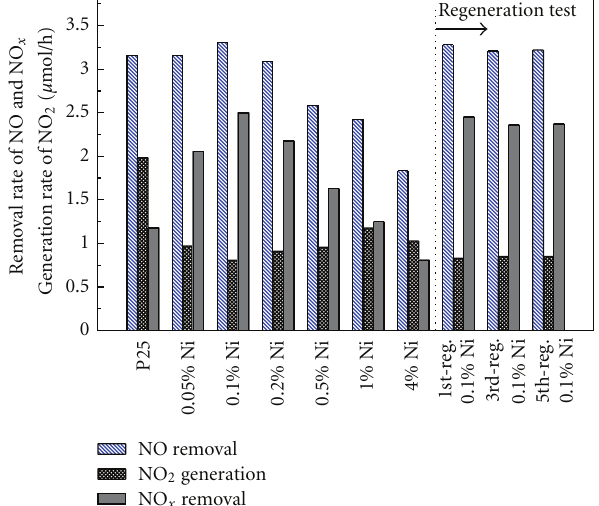
Figure 3: E ff ect of Ni content and regeneration time on the removal rate of NO x .